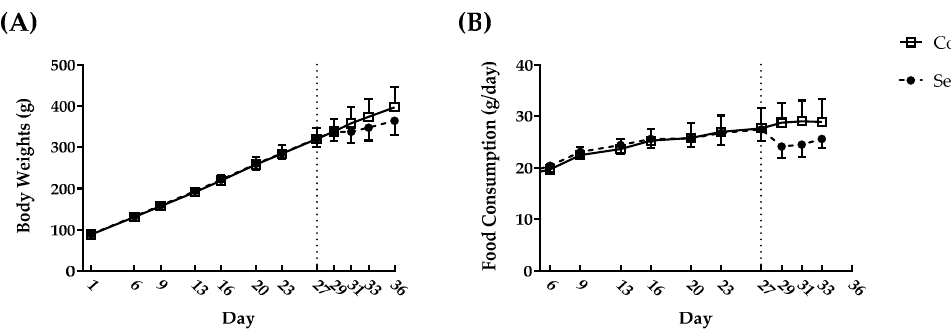
Figure 2. Time-course changes of the body weights ( A ) and food consumption ( B ) in the control and Se / GSH-depleted rats. ( A ) Day 1 means the day the study was initiated. ( B ) Food consumption on Day 6 was calculated between Days 1 and 6. Day 9: Days 6–9, Day 13: Days 9–13, Day 16: Days 13–